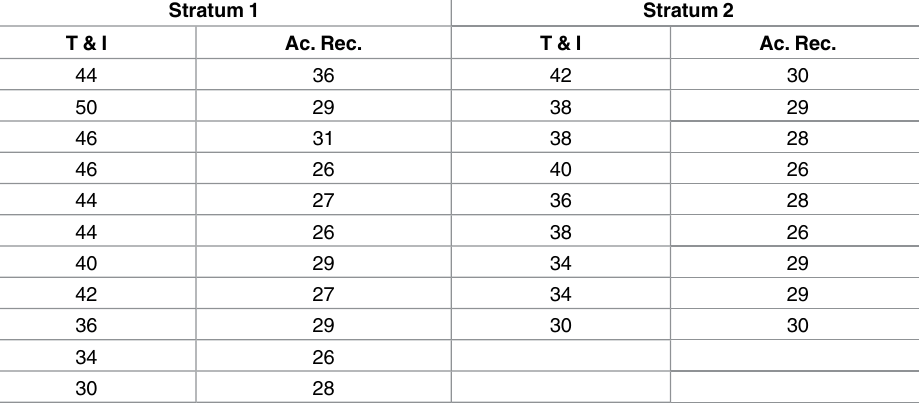
Table 1. Test and Interview marksMaster of Philosophy, Dept. of Statistics, QAU Islamabad, Fall 2014. Stratum 1 Stratum 2 T & I Ac. Rec. T & I Ac.